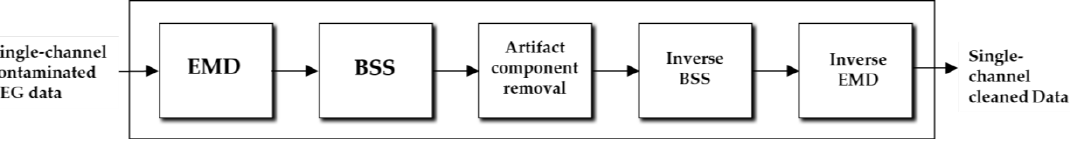
Figure 4. Process flow of EMD-BSS method.